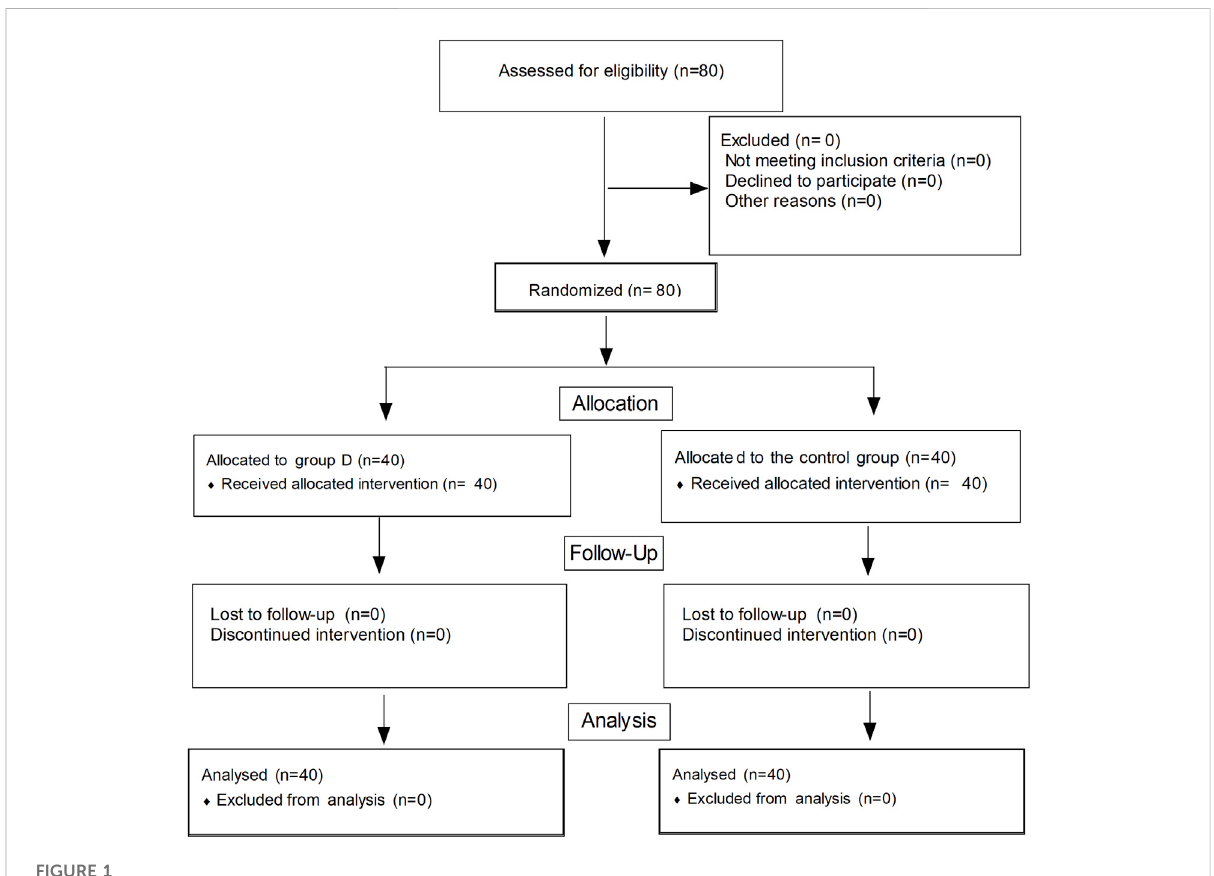
FIGURE 1 Flow diagram of the